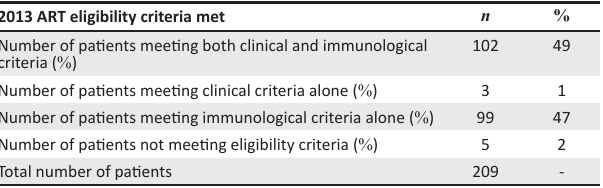
TABLE 3: Patients meeting 2013 combination antiretroviral therapy clinical or immunological eligibility